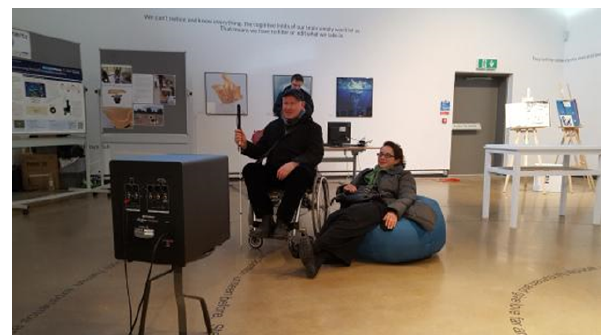
Figure 6. Two people experience the effect of infrasound played through the transducer and large subwoofer in a gallery space. They both face a subwoofer that fills the room with a low-frequency re- verberation of